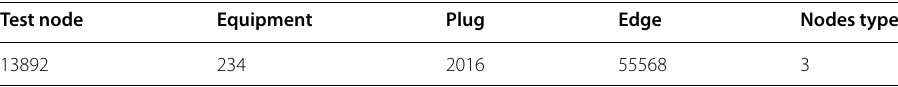
Table 3 Datasets on heterogeneous graph Test